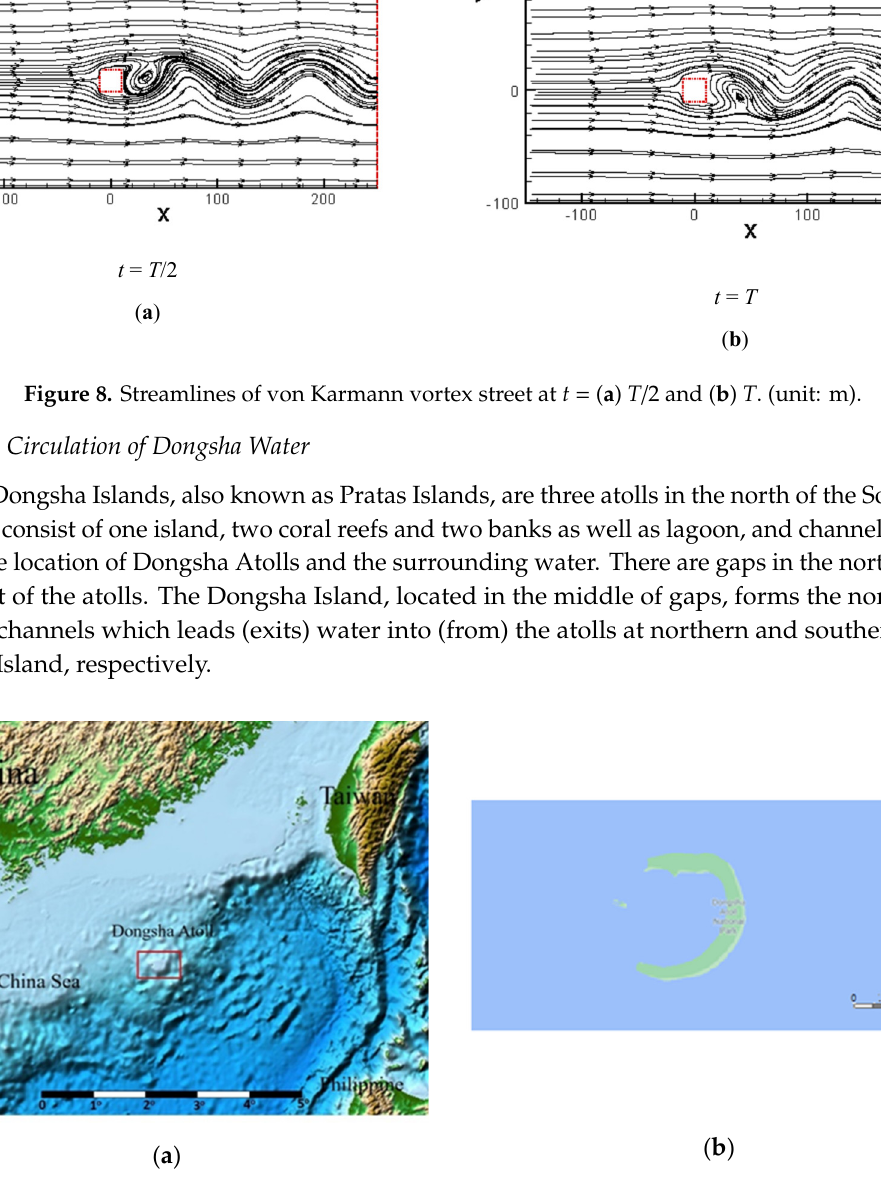
Figure 7. Contours of ( a ) U and ( b ) V of von Karmann vortex street at t = T/ 2 and T , respectively. ( U - contours ranges from −0.10 to 0.30 m/s with interval 0.05 m/s; V -contours ranges from –0.25 to 0.25 m/s with interval 0.05 m/s.) (unit: m).